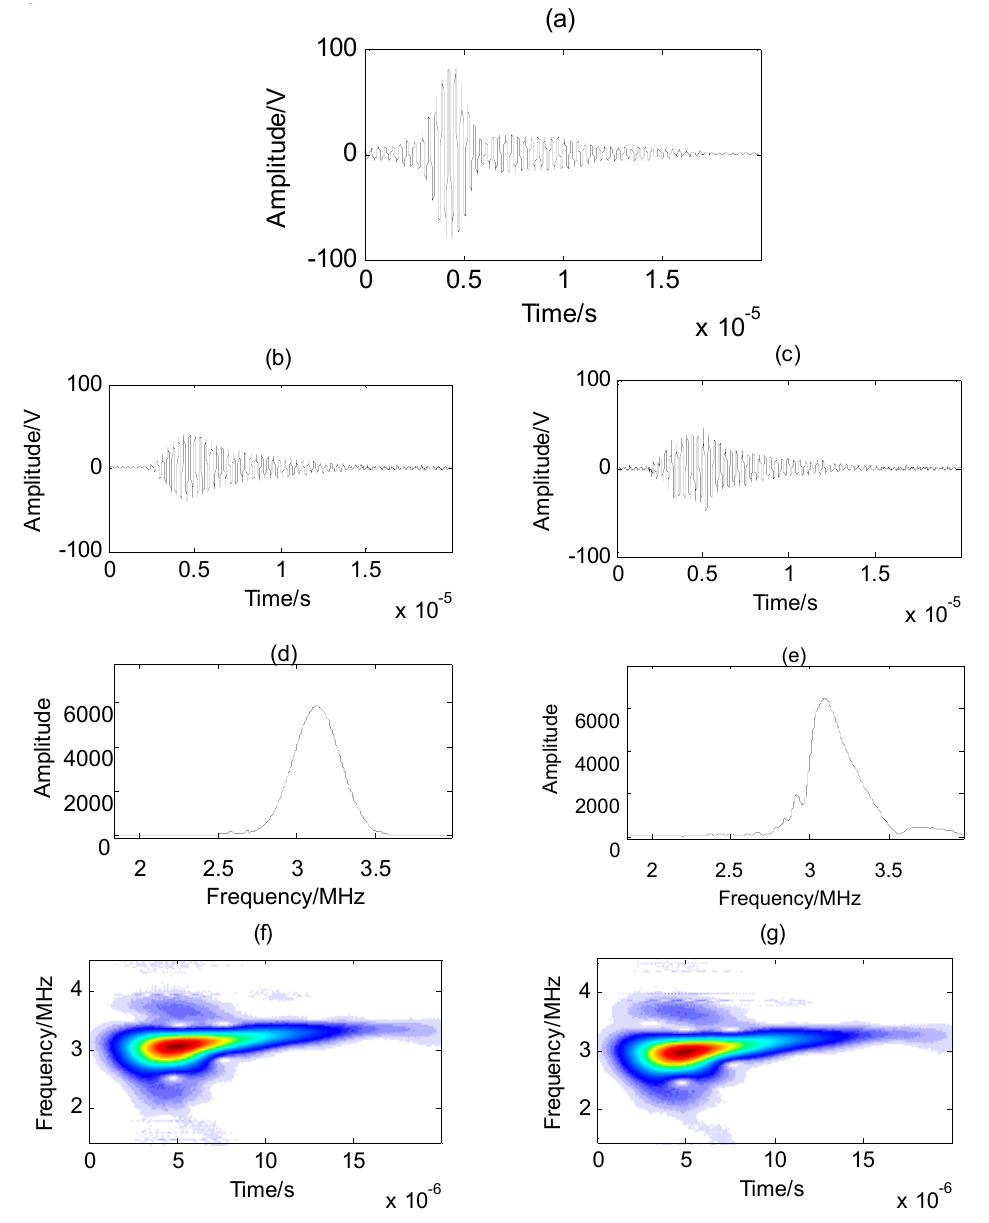
Figure 5. ( a ) The compensated multimodal Lamb wave signal at the distance of 2.7 cm; ( b ) separated S 1 mode time domain waveform using the proposed method; ( c ) separated S 1 mode time domain waveform using the time-frequency blind signal separation method; ( d ) amplitude spectrum of S 1 mode separated using the proposed method; ( e ) amplitude spectrum of S 1 mode separated using the time-frequency blind signal separation method; ( f ) time-frequency distribution of S 1 mode separated using the proposed method; ( g ) time-frequency distribution of S 1 mode separated using the time-frequency blind signal separation